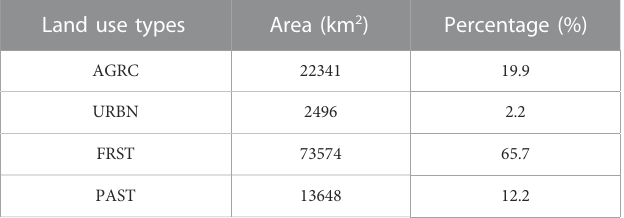
TABLE 2 Statistic result of the area and percentage of land use types in 2018. Land use